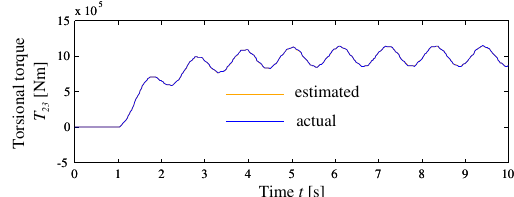
Figure 10. Torsional torque at parameter error − 20%.